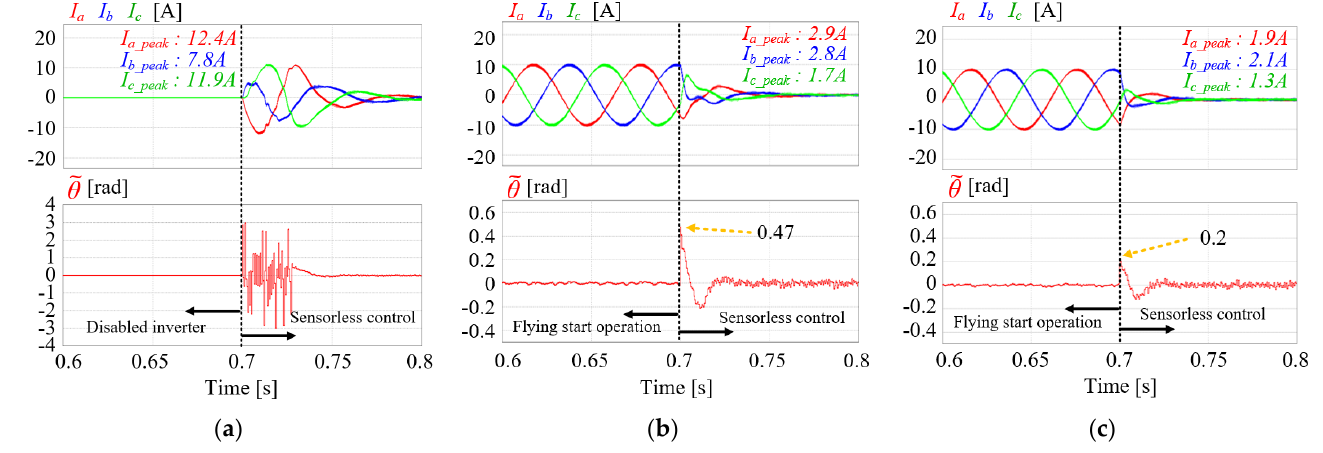
Figure 12. A comparison of the stator current and input of the position/speed estimator during mode transition. ( a ) Without flying start; ( b ) the VR-based flying start method; and ( c ) the proposed flying start method.